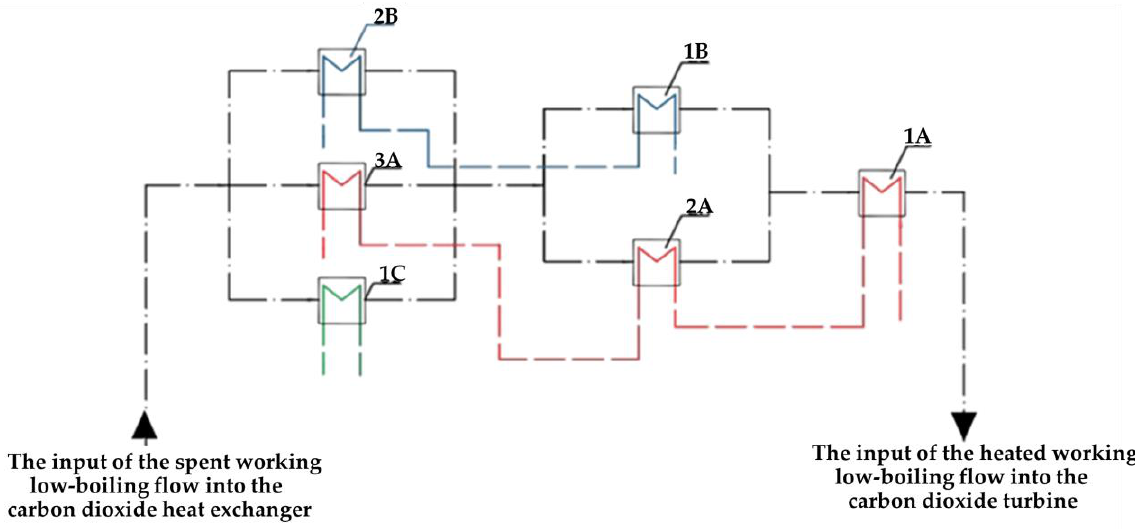
Figure 6. Scheme of the Allam cycle LGH joint utilization with gasification and utilization of the generator gas heat in nitrogen gas turbines.